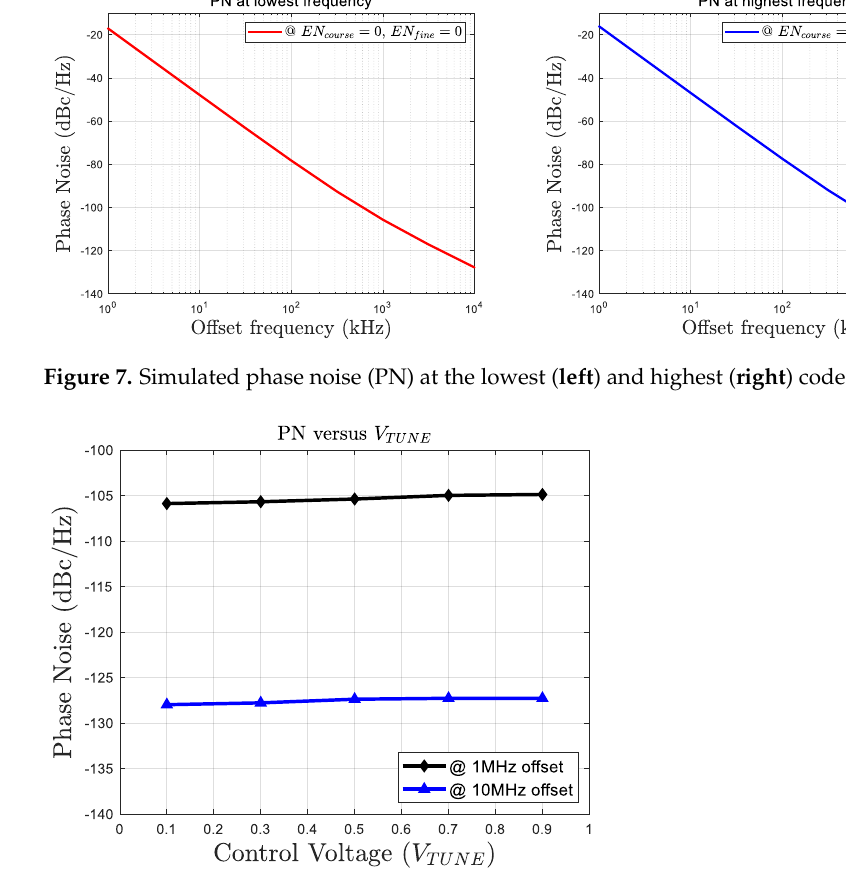
Electronics 2023 , 12 , x FOR PEER REVIEW 6 of 9 Figure 6. Simulated frequency tuning range ( left ) and 𝐾 𝑉𝐶𝑂 ( right ). The phase noise performance of the proposed VCO is simulated at both the lowest and highest digital code settings. As shown in Figure 7, the phase noise of the VCO is